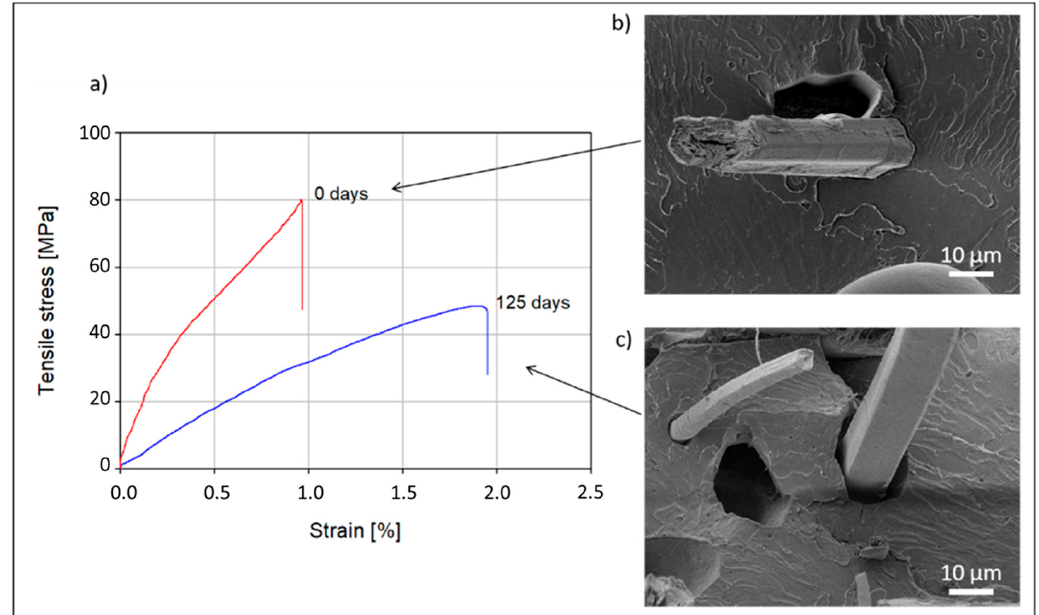
Figure 2. ( a ) Mechanical property evolution of a non-woven flax/PLA composite after spending 125 days in a garden compost; ( b , c ) SEM micrographs of nitrogen cryo-fractured samples, showing the interface between flax fibre and PLA before ( b ) and after ( c ) compost ageing.